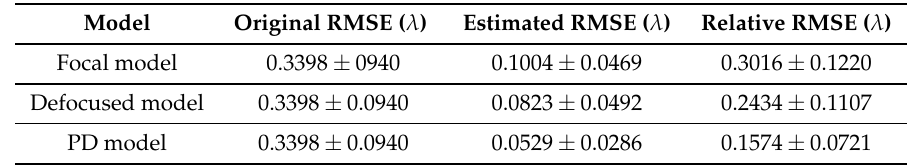
Table 4. Summary of accuracies (Root Mean Square Error (RMSE) and standard error: λ of Zernike coefficients estimated by PD-CNN across 3000 samples.